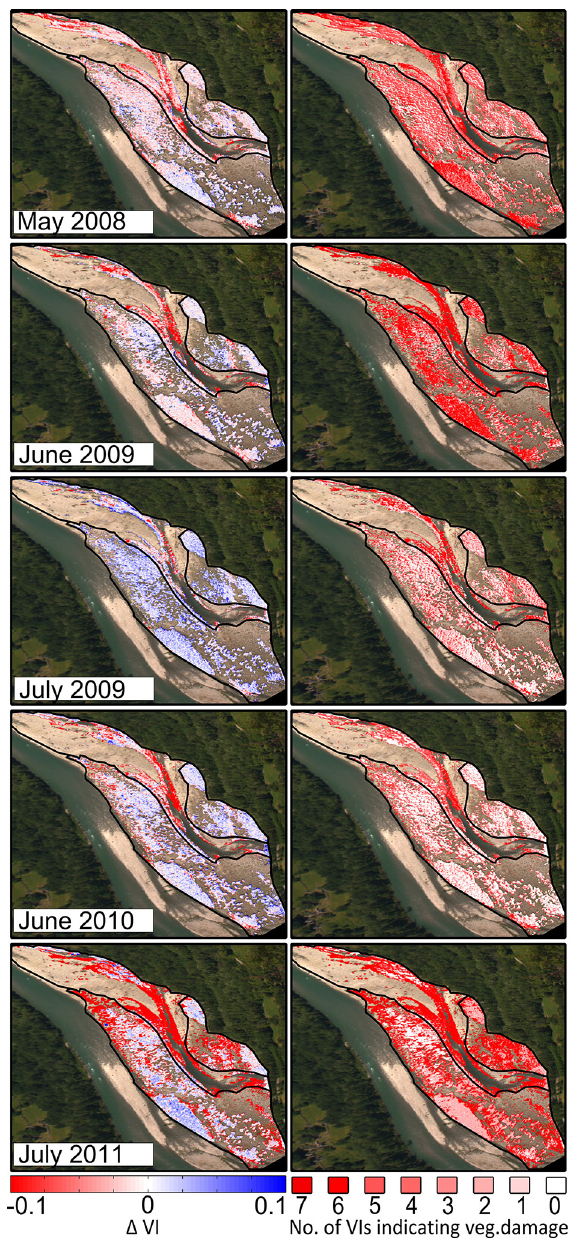
Figure 7. Left-column panels: spatial distribution of vegetation response (cid:49) VI to each flood (displayed VI values correspond to the NDVI). (cid:49) VI < 0 (red colour) indicates vegetation damage and (cid:49) VI > 0 (blue colour) vegetation enhancement. Right-column pan- els: spatial distribution of number of studied vegetation indices pre- dicting vegetation damage after each flood. Threshold for vegetation delineation: NDVI > 0 . 5. Floods are listed according to the time of their occurrence. Base image: camera image from 1 June 2009; the reference pre-flood and post-flood images are added in the Supple- ment. The black lines delineate floodplain units from left: main bar, transitional zone, secondary